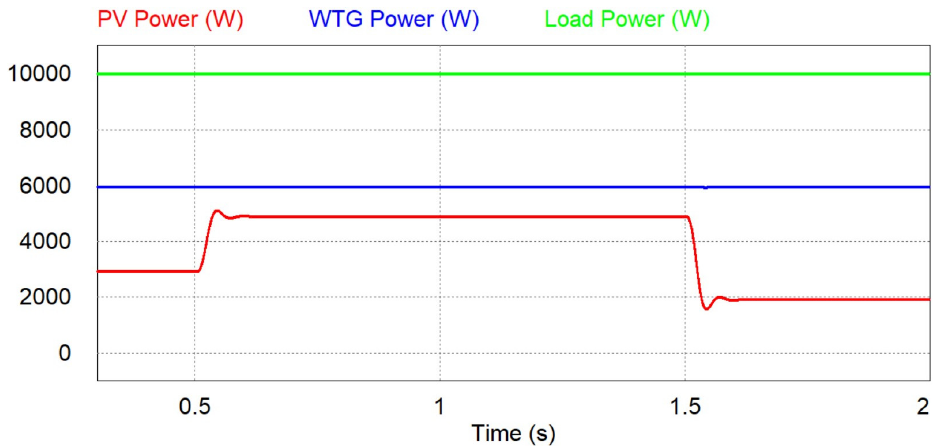
Figure 9. The power of PV, WTG, and load—Case 1.